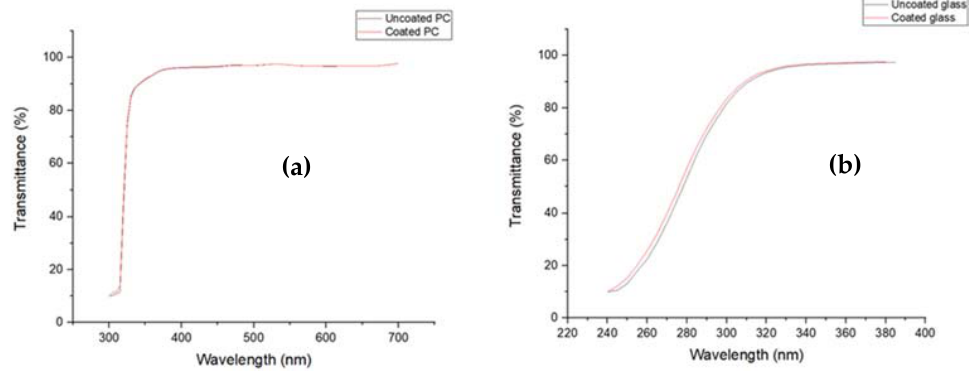
Figure 6. Transparency analysis tests via UV–vis of PMBL films on ( a ) PC substrates (coating thickness = 2.6 μ m) and ( b ) glass substrate (coating thickness = 4.2 μ m).